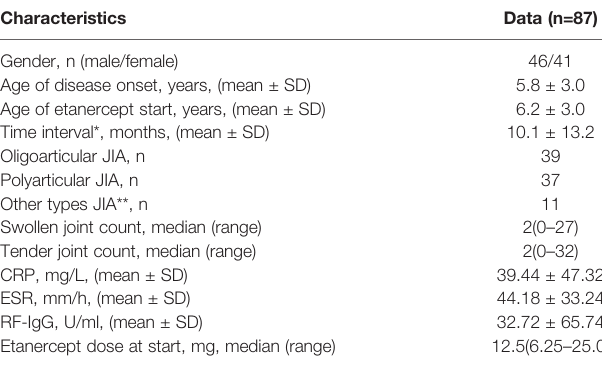
TABLE 1 | Baseline characteristics of 87 patients.